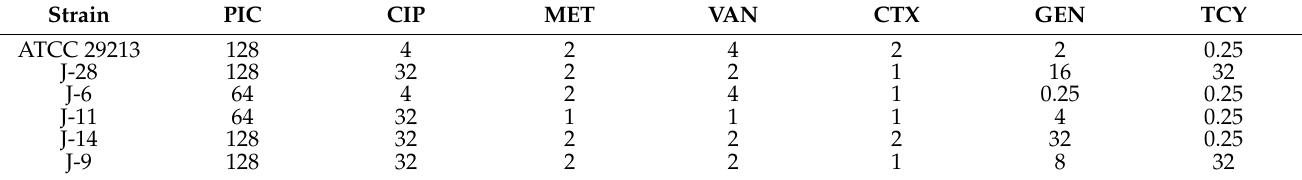
Table 1. Minimum inhibitory concentrations of piceatannol and several antibiotics against Staphylo- coccus aureus ( µ